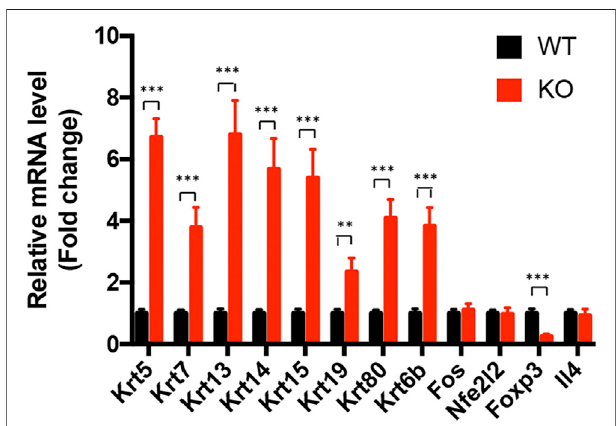
FIGURE 7 | Transcriptional validation of the differentially expressed genes in Asrgl1 KO mice. The expression of Krt5, Krt7, Krt13, Krt14, Krt15, Krt19,andKrt80inglucocorticoidreceptorsignalingpathwayandthe “ central node ” genes, NFE2L2, IL-4, Foxp3, and Fos, in the interaction network between WT and Asrgl1 KO mice ( n (cid:1) 6) was validated by real-time PCR. A two-tailed Student ’ s t -test was used; pp p < 0.01; ppp p < 0.001. Data were from an average of four samples per group. Each test was repeated at least three